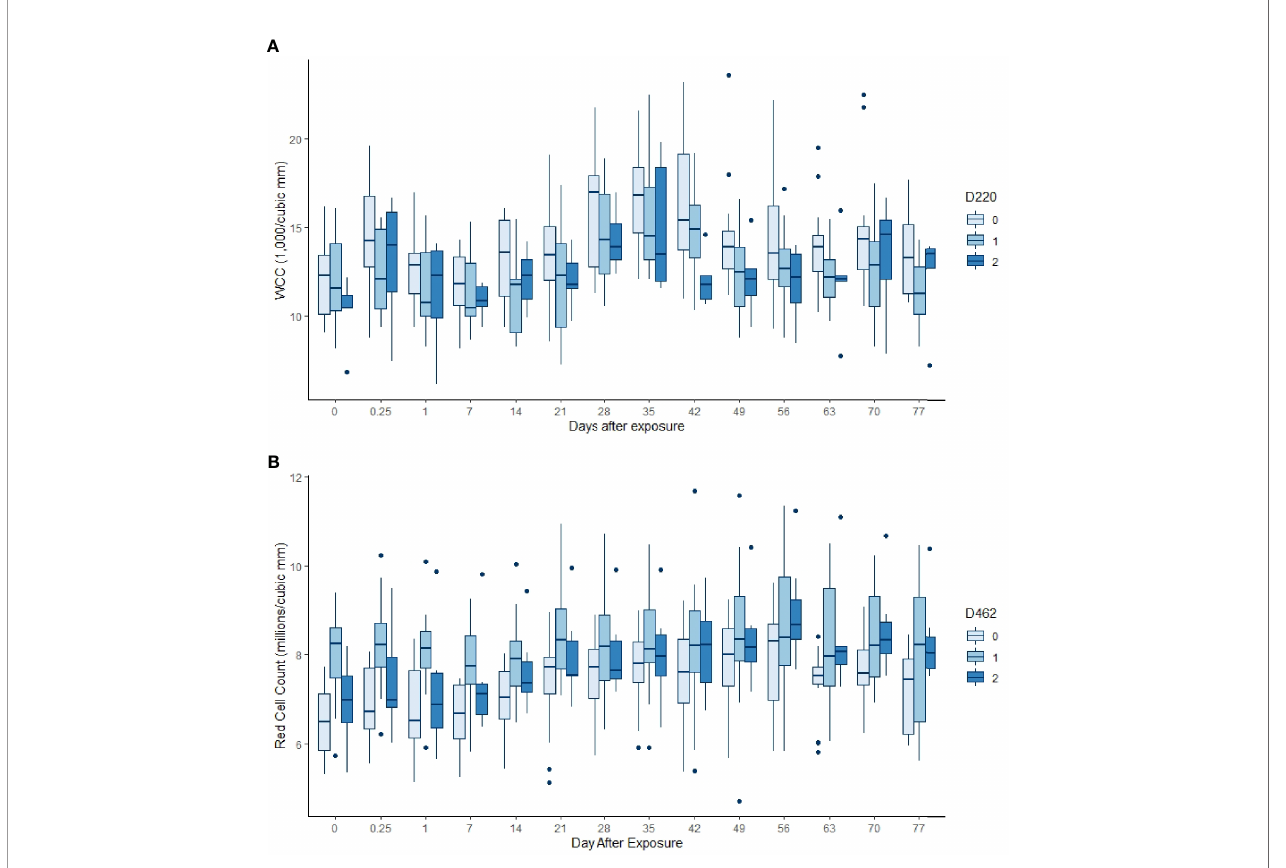
FIGURE 3 | (A) White cell counts by day, commencing pre-infestation and continuing for 11 weeks. Data for the 220 allele are shown, those animals without the allele in palest blue, and animals that were 220/220 in the darkest blue. Both day and the allele dose were highly signi fi cant in the GAM ( p < 0.00083, Table 5 ). (B) Red cell counts by day, commencing pre-infestation and continuing for 11 weeks. Data for the 462 allele are shown, those animals without the allele in palest blue, and animals that were 462/462 in the darkest blue. Both day and the allele dose were highly signi fi cant terms in the GAM ( p < 0.00083, Table 5 ).